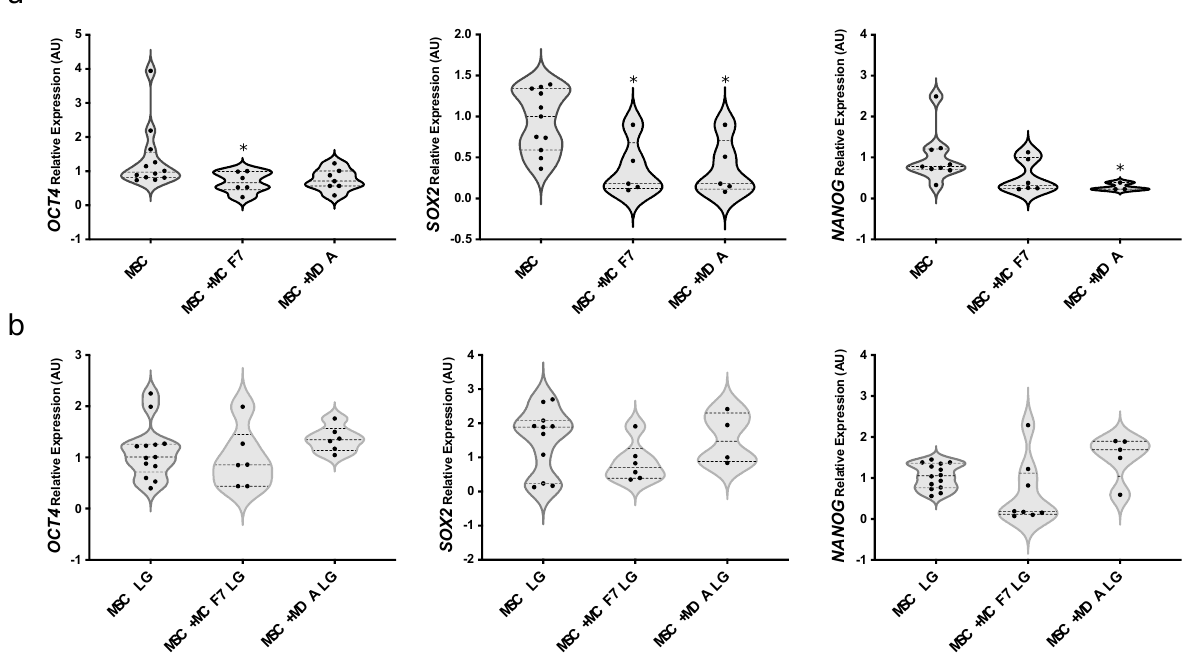
Figure 3. Effect of glucose on MAT - MSCs multipotency in 2D cultures with BC cells. MAT-MSCs were co-cultured—and not—with MCF7 or MDA-MB231 BC cells in ( a ) standard/high glucose (25 mM glucose; MSC) or ( b ) low glucose concentration (5.5 mM; MSC LG). After for 72 h, mRNA expression levels of multipotency markers ( OCT4, SOX2, NANOG ) were determined by qPCR (see Methods and Supplementary Table S1). Data were normalized on PPIA gene as internal standard. Results were represented as violin plot of 7–9 independent triplicate experiments showing mRNA levels of OCT4, SOX2 and NANOG in MAT-MSCs co-cultured with BC cells as relative expression (2 − ∆∆ Ct ) compared to that in mono-cultured MAT-MSCs. Data were analyzed using non-parametric Kruskall–Wallis test followed by Dunn’s correction for multiple comparisons. * denotes statistically significant values compared with MSC (* adjp <